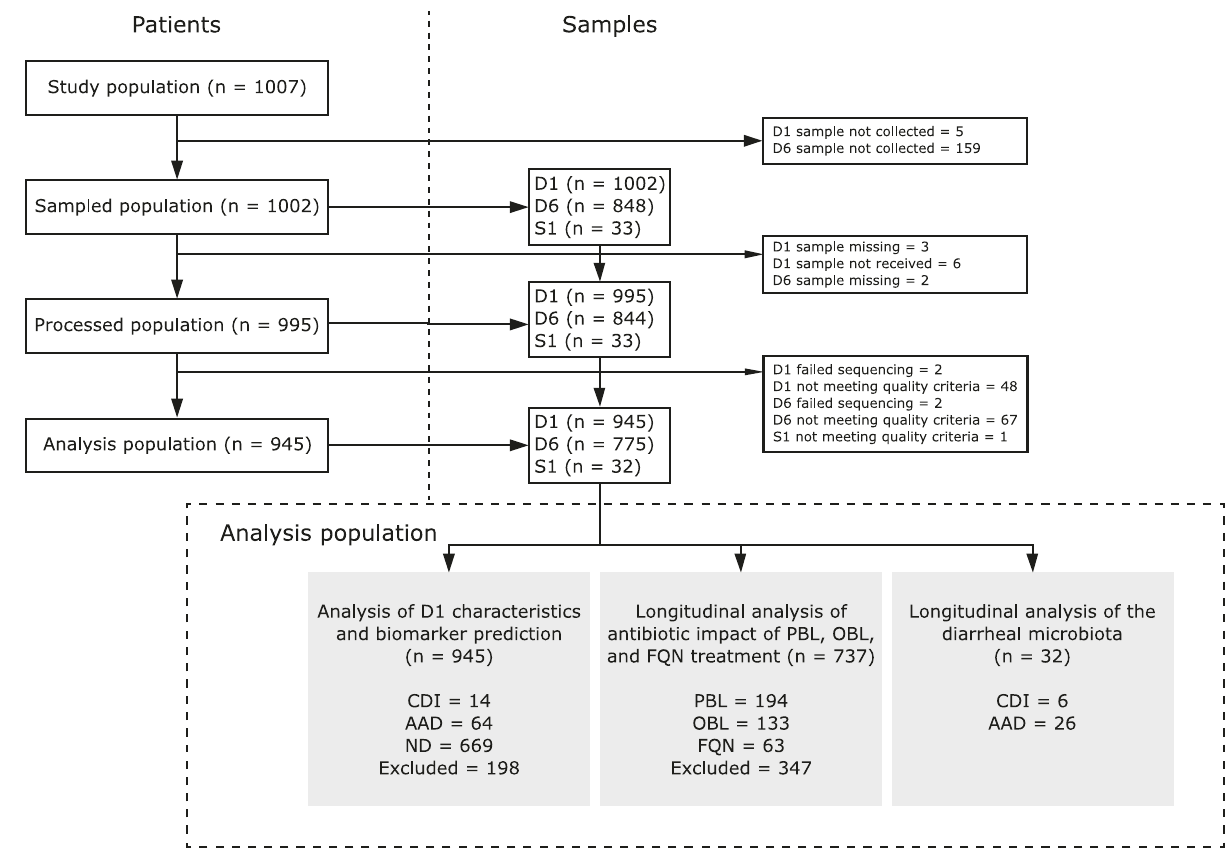
Fig. 1 Patient and sample fl ow in the study. The fl ow chart provides an overview of participating patients in each processing step, number of samples collected at each timepoint, and reasons for sample exclusion or non-collection. D1: rectal swab sample collected upon study enrollment. D6: rectal swab collected ~6 days after initiation and at the end of antibiotic treatment. S1: stool sample collected at the fi rst occurrence of diarrhea (variable time-point). AAD: patients with non- C. dif fi cile antibiotic-associated diarrhea. CDI: patients with con fi rmed C. dif fi cile infection. ND: non-diarrheic patients. PBL: penicillin + beta-lactamase inhibitor. OBL: other beta-lactamase antibiotics. FQN: fl